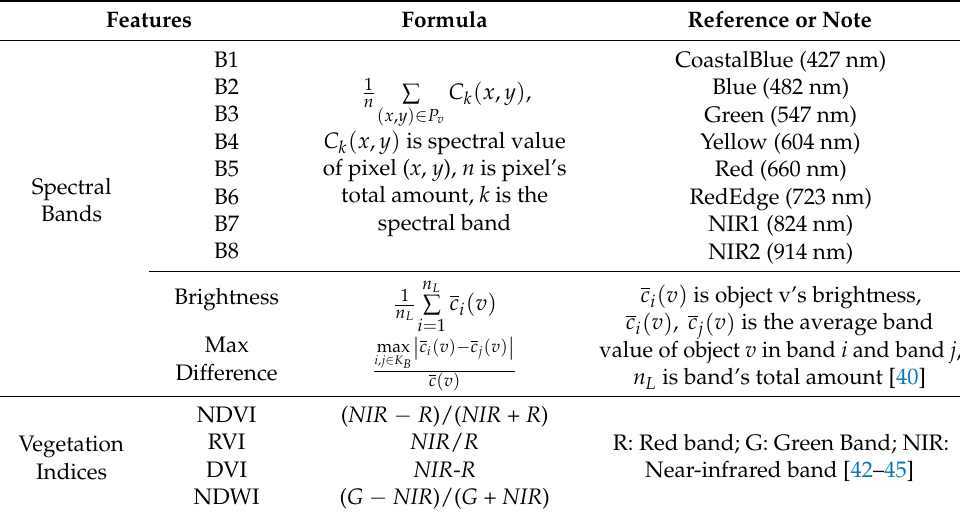
Table 1. Selected spectral and vegetation indices for the CART decision tree